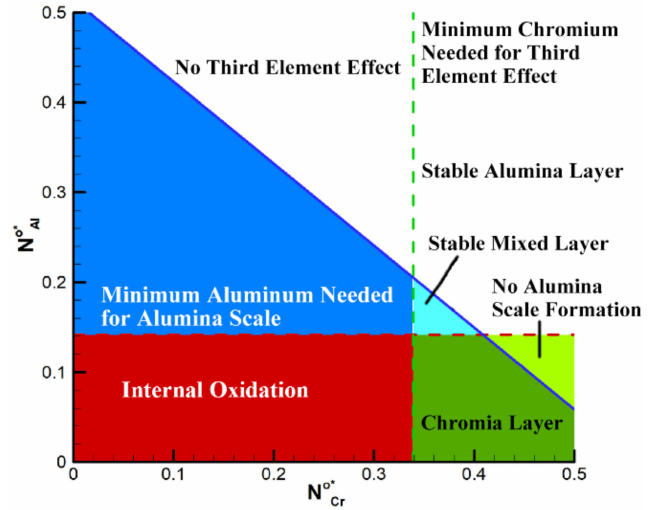
Figure 11. Interpretive visualization of the third element phenomenon in the Fe-Al-Cr alloy system, predicting the type of oxide scale formed as a function of Al and Cr content